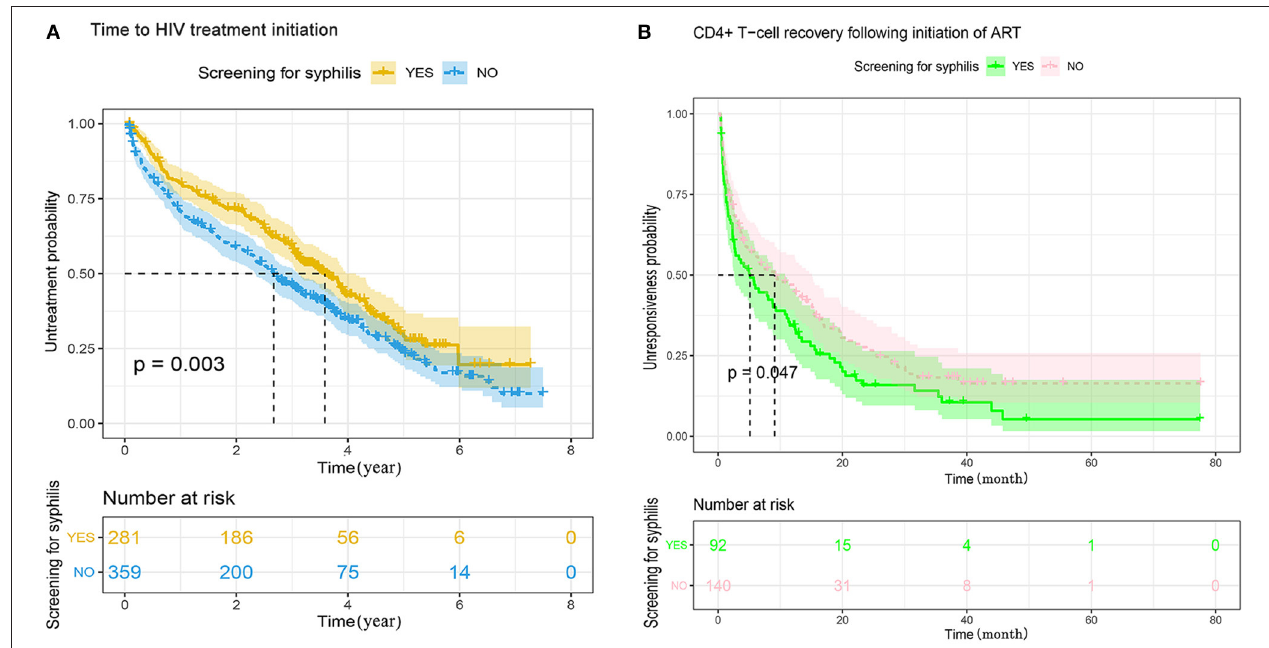
FIGURE 2 | (A) Kaplan–Meier analysis of the time to initiate antiretroviral treatment between MSM with or without syphilis screening in Guangzhou, China, 2008–2012. The date of HIV-1 diagnosis was defined as time zero. The tick marks indicate the participants with censored data. P -values were calculated by the log-rank test. The median time to initiate ART was 2.7 years (range 2.3-3.0) for MSM without syphilis testing, and 3.6 years (range 3.1-4.1) for MSM with syphilis screening, respectively. MSM, men who have sex with men; HIV, human immunodeficiency virus. (B) Kaplan–Meier analysis of the time from CD4 + count < 350–350 cells/ µ L following ART between MSM with or without syphilis screening. The date of ART initiation was defined as time zero. The tick marks indicate the participants with censored data. P -values were calculated by the log-rank test. The median time from CD4 + T-cell count < 350– ≥ 350 cells/ µ L was 9.1 months (range 4.3-13.9) for the patients without syphilis testing, and 5.1 months (range 1.8-8.5) for the patients with syphilis